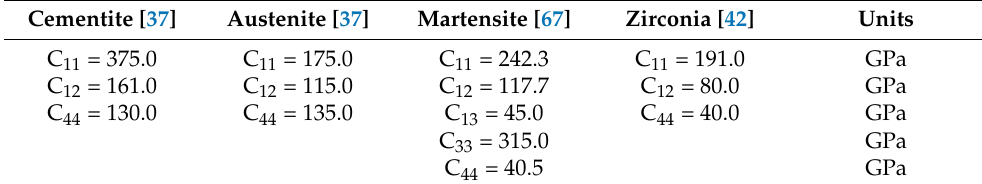
Table A3. Single crystal elastic constants for austenite, martensite, and zirconia incorporated in